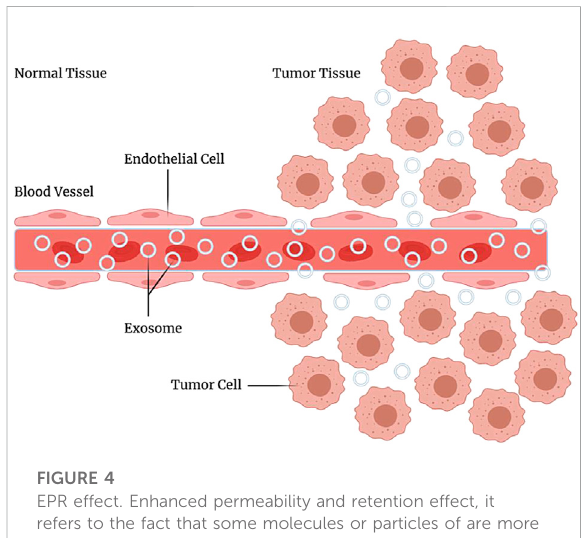
FIGURE 4 EPR effect. Enhanced permeability and retention effect, it refers to the fact that some molecules or particles of are more likely to aggregate in tumor tissue than in normal